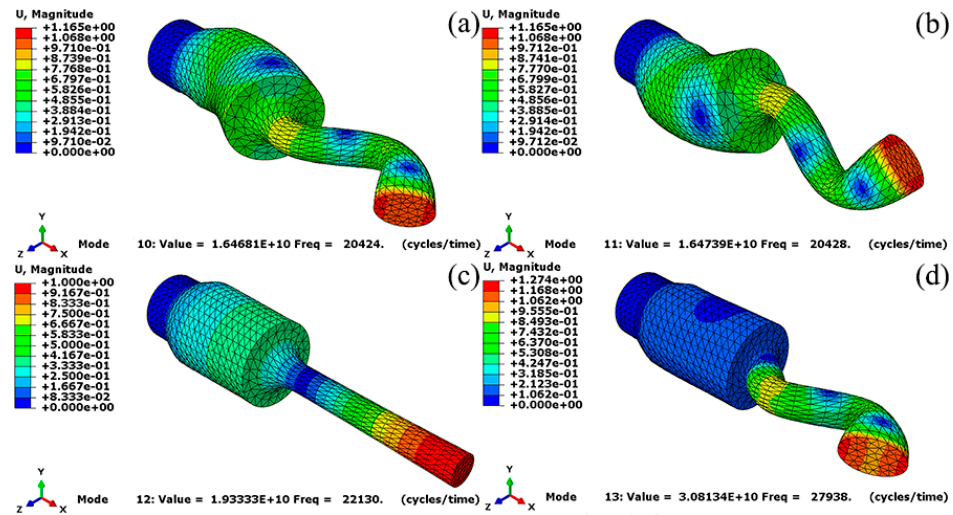
Figure 5. Cloud diagram of horn vibration mode of the 10–13 modes, ( a ) 10 mode, ( b ) 11 mode, ( c ) 12 mode, ( d ) 13 mode.